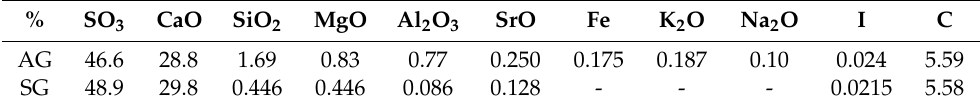
Table 3. Chemical composition of gypsum powders.